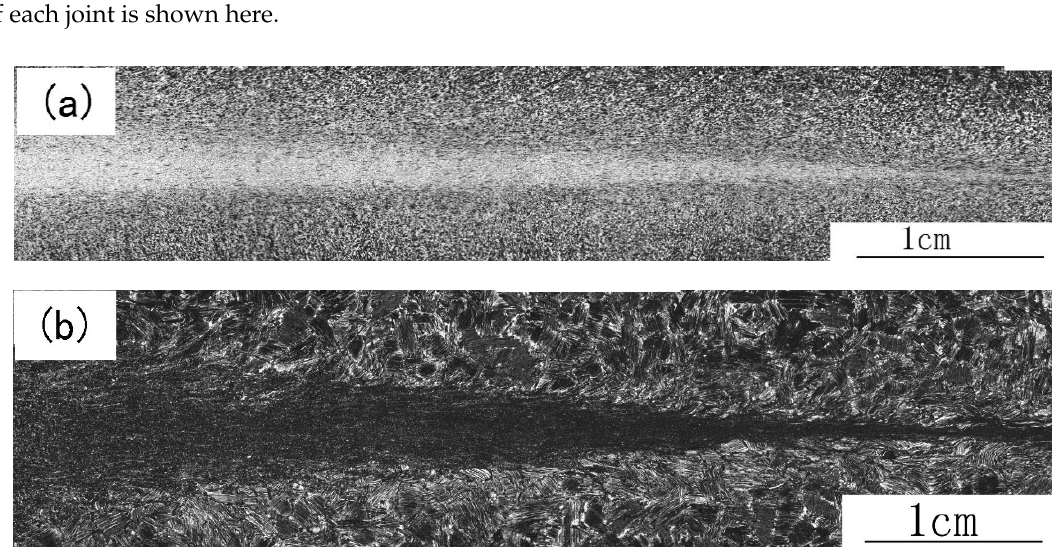
Figure 5. Macrostructures of the welded joints: ( a ) the as-forged alloy; ( b ) the as-cast alloy.